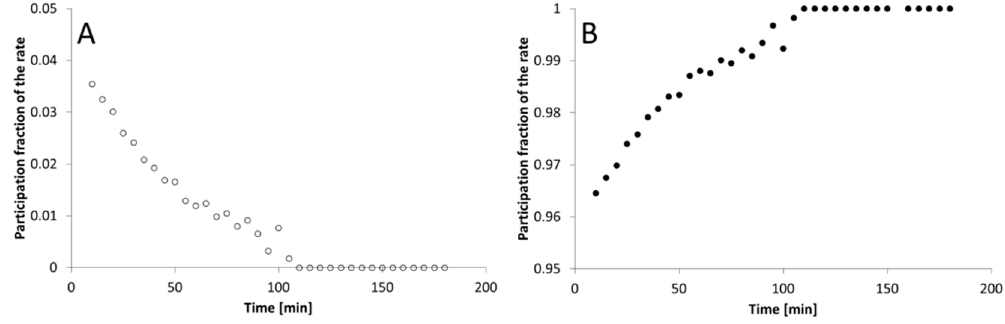
Figure 3. Decrease of k ₁ participation in the kinetics process ( A ), and increase of k ₀ participation in the kinetics process ( B ) in the total release process depending on time for the preparation FEP1.